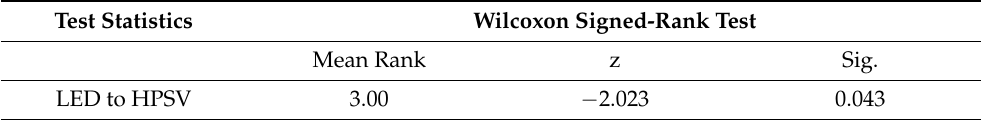
Table 8. The Wilcoxon Signed-Rank Test of technical efficiency score for HPSV and LED Road